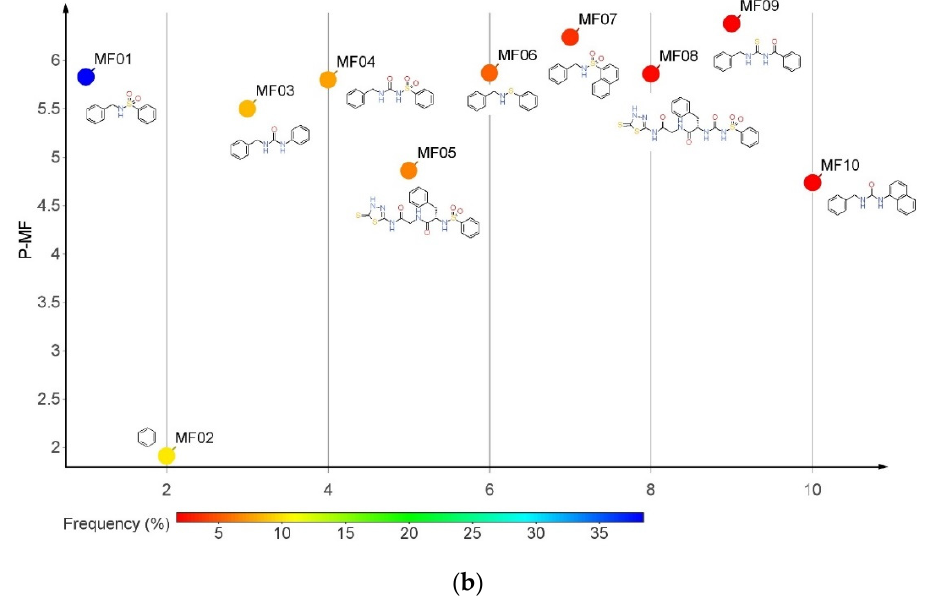
Figure 1. The Murcko framework structures: ( a ) The architecture types (I-IV) of the MF skeletons; ( b ) the performance score (P-MF) in relation with the frequency of distribution in the BCI set for MF01-MF10.